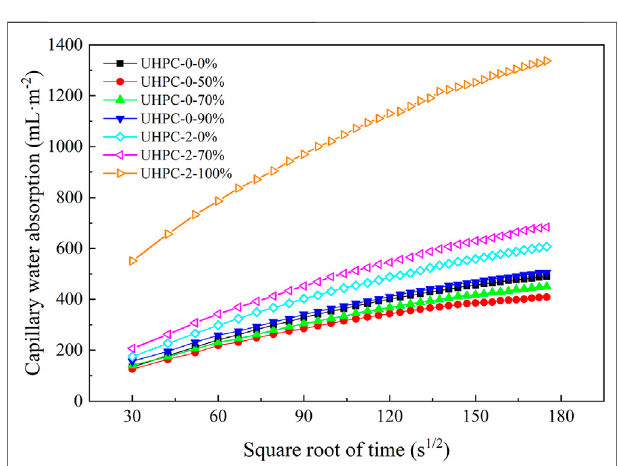
FIGURE 6 | Typical plot for the capillary water absorption test.